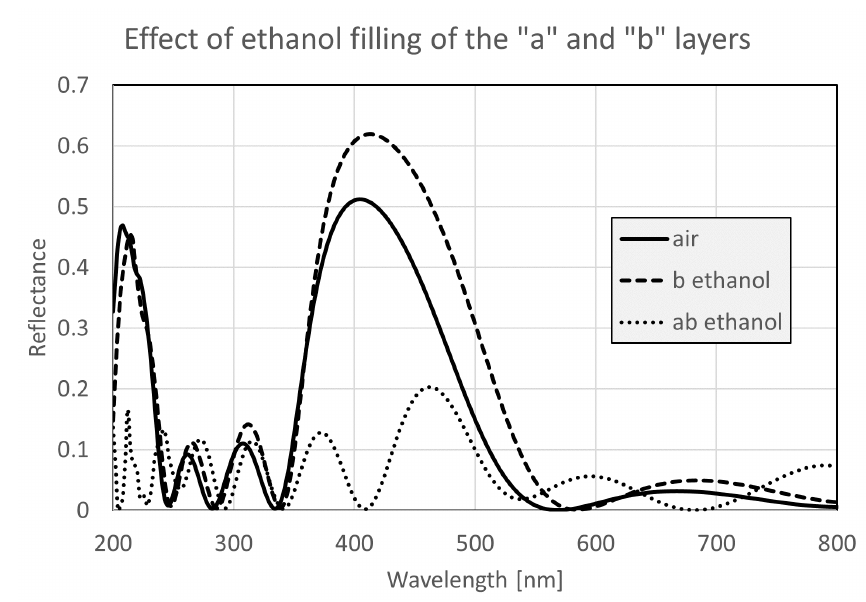
Figure 5. Effect of the ethanol filling of the “A” and “B” layers on the FEM calculated reflectance of one dorsal scale. Solid line: voids in both the “A” and “B” layers are filled with air. Dashed line: voids in the “B” layers are filled with ethanol. Dotted line: voids in both the “A” and “B” layers are filled with